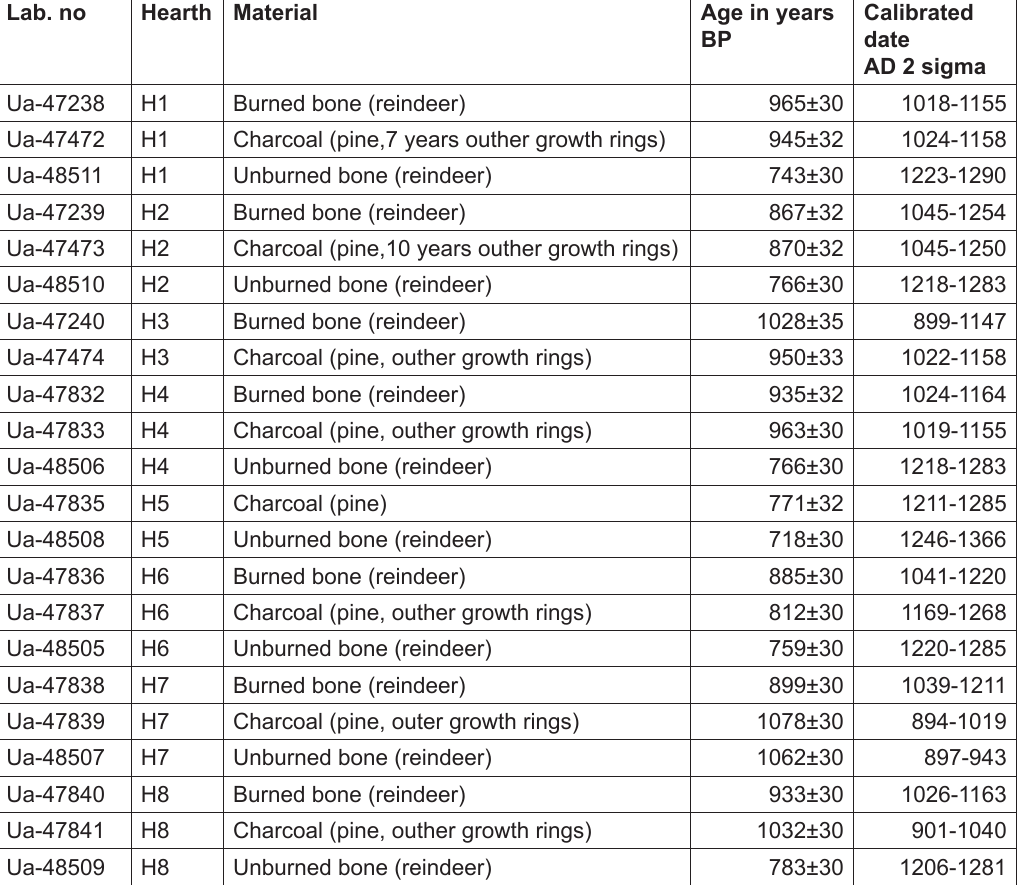
Table 8. AMS radiocarbon dates from Steintjørna. All the dates were processed at the Ångström Laboratory in Uppsala, Sweden. Dates calibrated with OxCal 4.2 (Bronk Ramsey 2009) Lab.